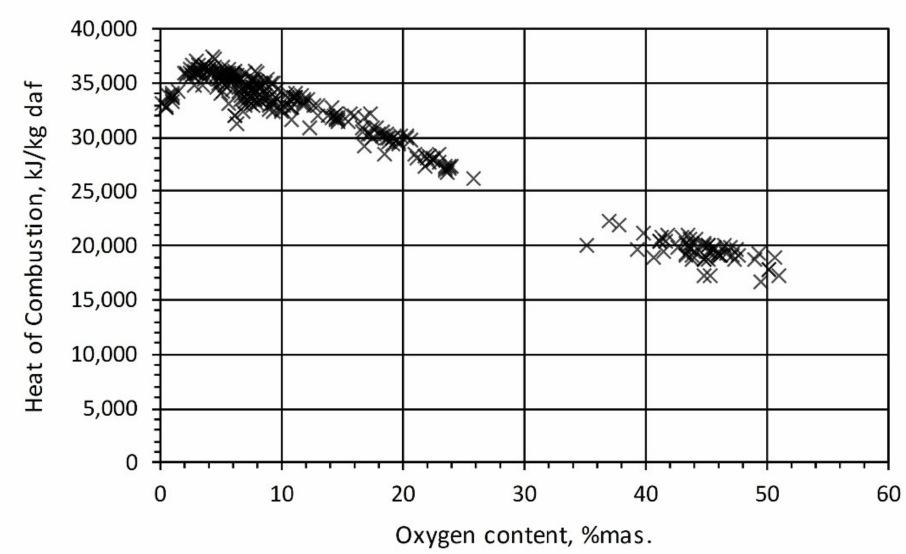
Figure 5. The effect of the oxygen content (daf) on the heat of fuel